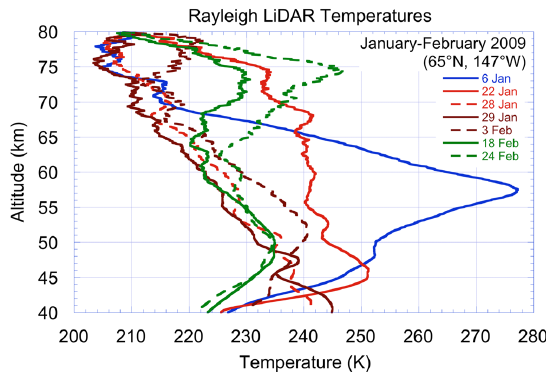
Figure 5. Rayleigh LiDAR temperature profiles for the seven nights of Rayleigh LiDAR data